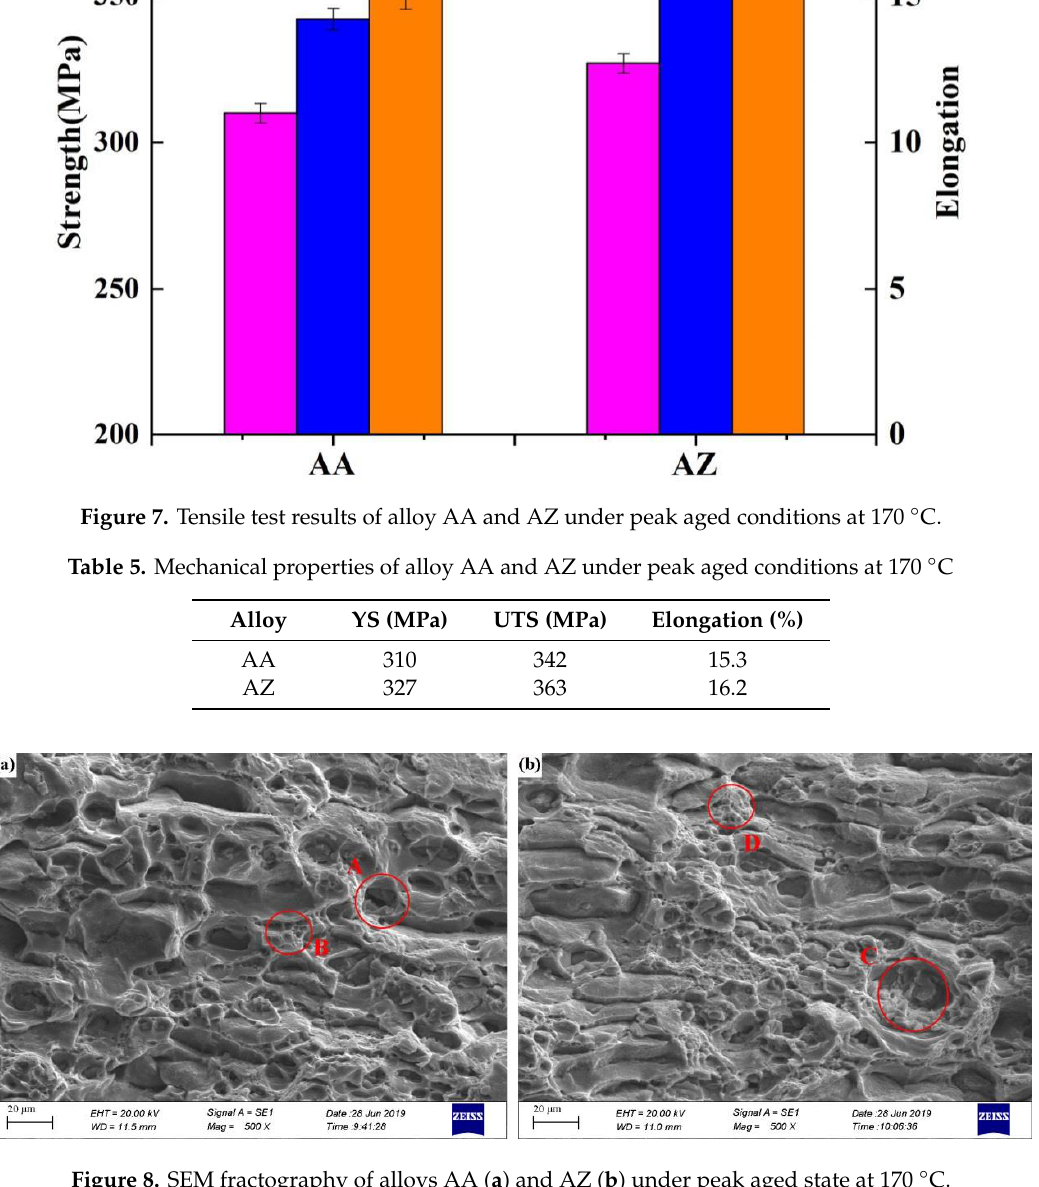
Figure 8. SEM fractography of alloys AA ( a ) and AZ ( b ) under peak aged state at 170 °C.